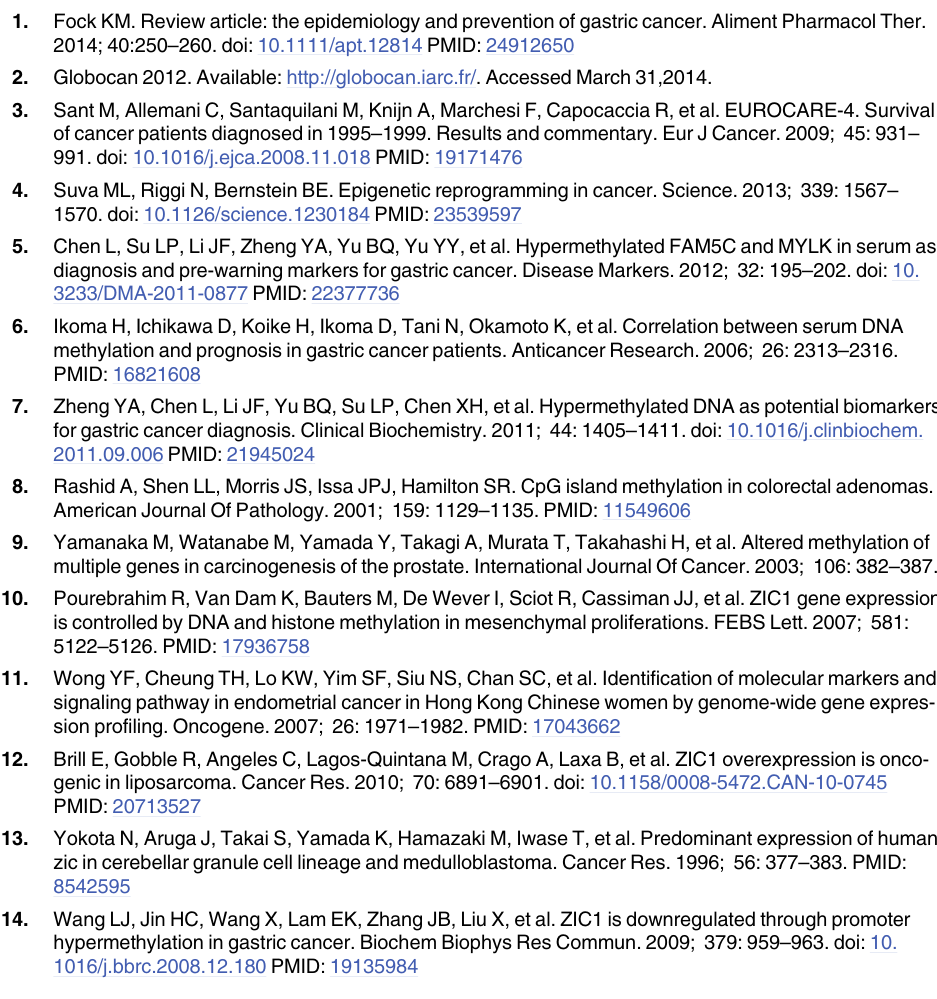
S2 Fig. Combined detection of Zic1 promoter methylation and the CEA level (tandem test- ing) in gastric cancer (GC) plasma specimens. An ROC curve for evaluating the significance of the combined detection of the two parameters (tandem testing) for GC diagnosis. S3 Fig. Detection of Zic1 promoter methylation in gastric intraepithelial neoplasia (GPI) plasma specimens. An ROC curve for evaluating the significance of the Zic1 promoter methyl- ation testing for GPI